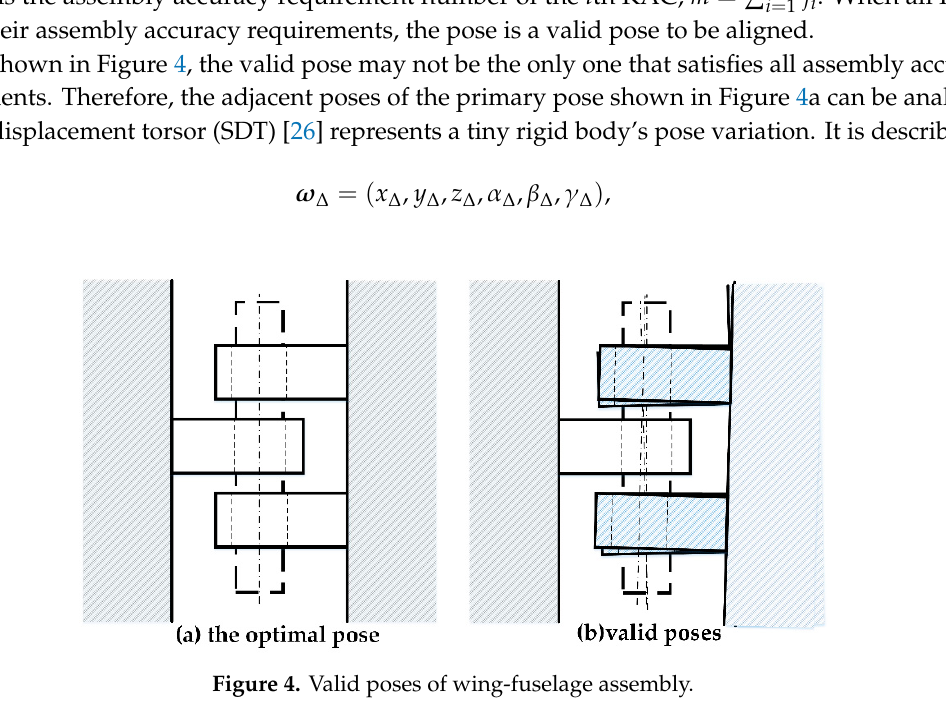
Figure 4. Valid poses of wing-fuselage assembly.